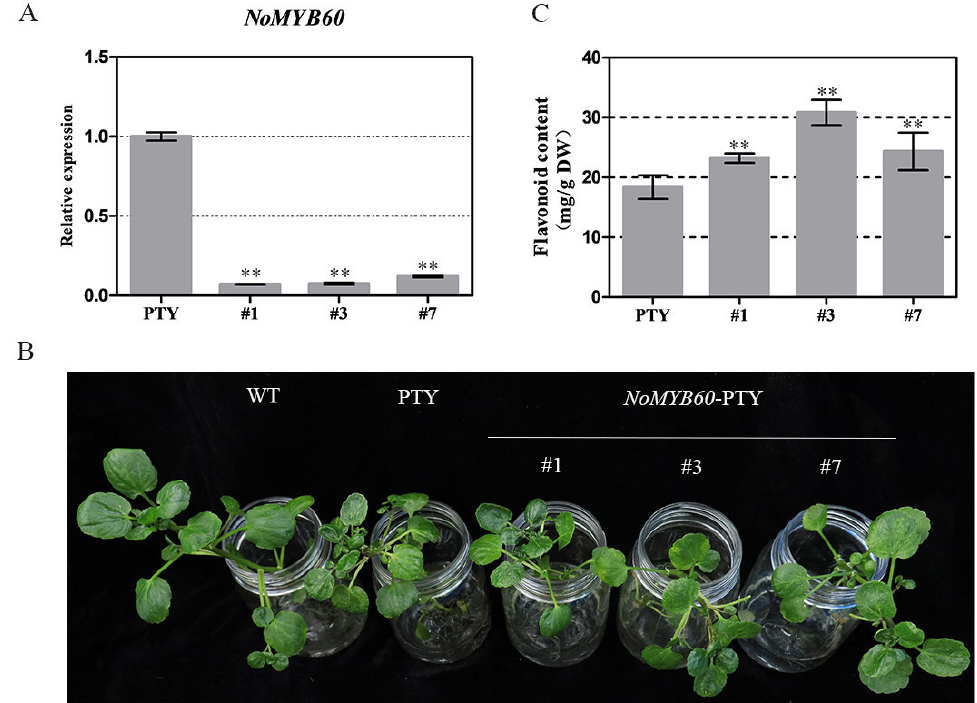
Figure 5. Virus-induced NoMYB60 silencing in watercress. ( A ) Relative expression of NoMYB60 in silent plants. Error bars represent standard errors. ( B ) Plant phenotype after silencing of NoMYB60 gene. ( C ) Flavonoid content in silenced plants (**, p < 0.05).